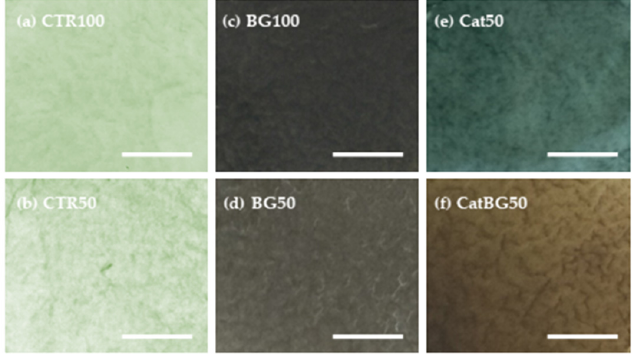
Figure 4. Photographs of the produced LbL freestanding films after cross-linking with genipin ( a ) CTR100, ( b ) CTR50, ( c ) BG100, ( d ) BG50, ( e ) Cat50, and ( f ) CatBG50. Scale bars represent 0.5 cm.